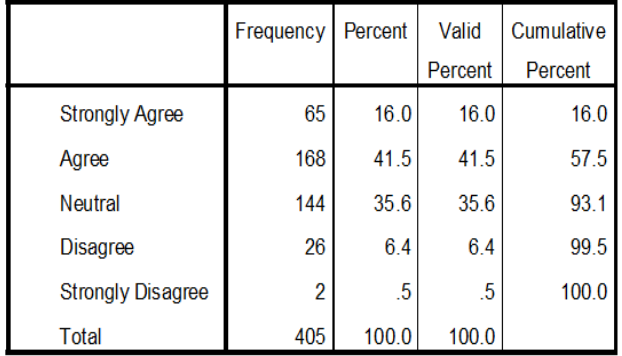
Figure 5. Company’s profits have been increasing from the last three years due to the change in the CIOs responsibilities